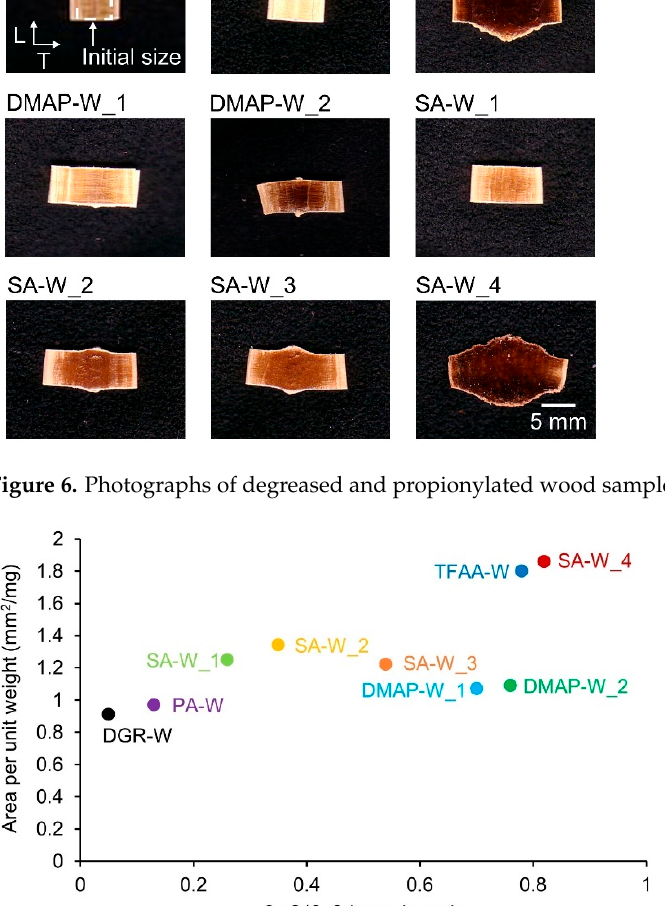
Figure 6. Photographs of degreased and propionylated wood samples after hot compression tests.